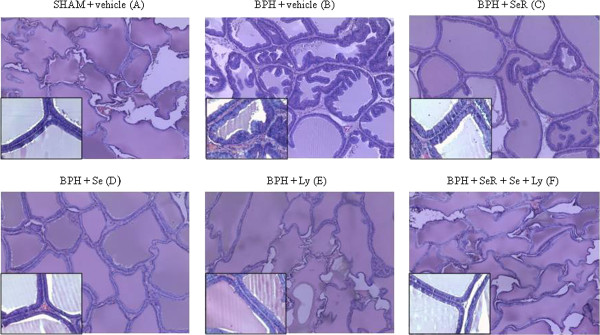
Histological findings. Sham prostate treated with vehicle showing regular acini with cubodail epithelium with round nuclei showing a regular alignment (A). BPH prostate treated with vehicle showed irregular acinar shape with villous projection into the lumen and foci of piling-up hyperplastic nodule with loss of epithelial polarity are evident. The epithelium is cylindric/cuboidal and round/ovoid nuclei are irregularly aligned. Presence of hard stroma and an intact basal layer surrounding the acini (B). Similarly, BPH prostate treated with SeR and Se displayed cilindric/cuboidal epithelial cells but villous projections are just slightly present or absent, respectively. Moderate stroma and intact basal layer around the acini (C-D). Treatment with Ly proved cuboidal epithelial cells, absence of villous projection and the presence of moderate stroma with intact basal layer around the acini (E). Differently, BPH prostate treated with the combination SeR-Se-Ly resembled the histological features of a normal acinar structure (F) (Original magnification ×100 and ×400 in the box).